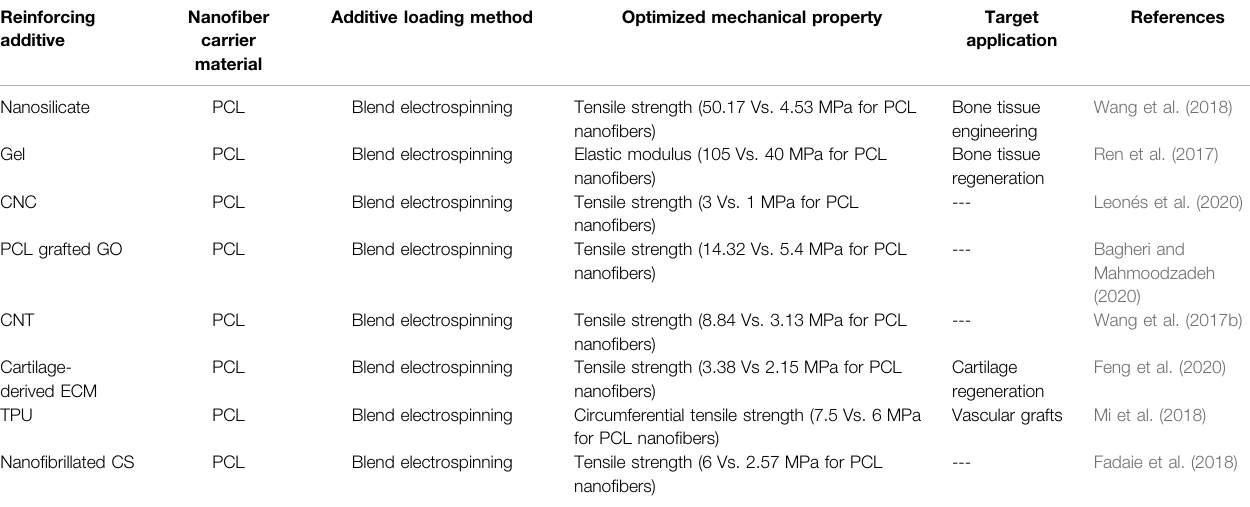
TABLE 1 | Mechanically stabilized PCL-based nano fi bers for biomedical applications (studies reported after 2017). Reinforcing